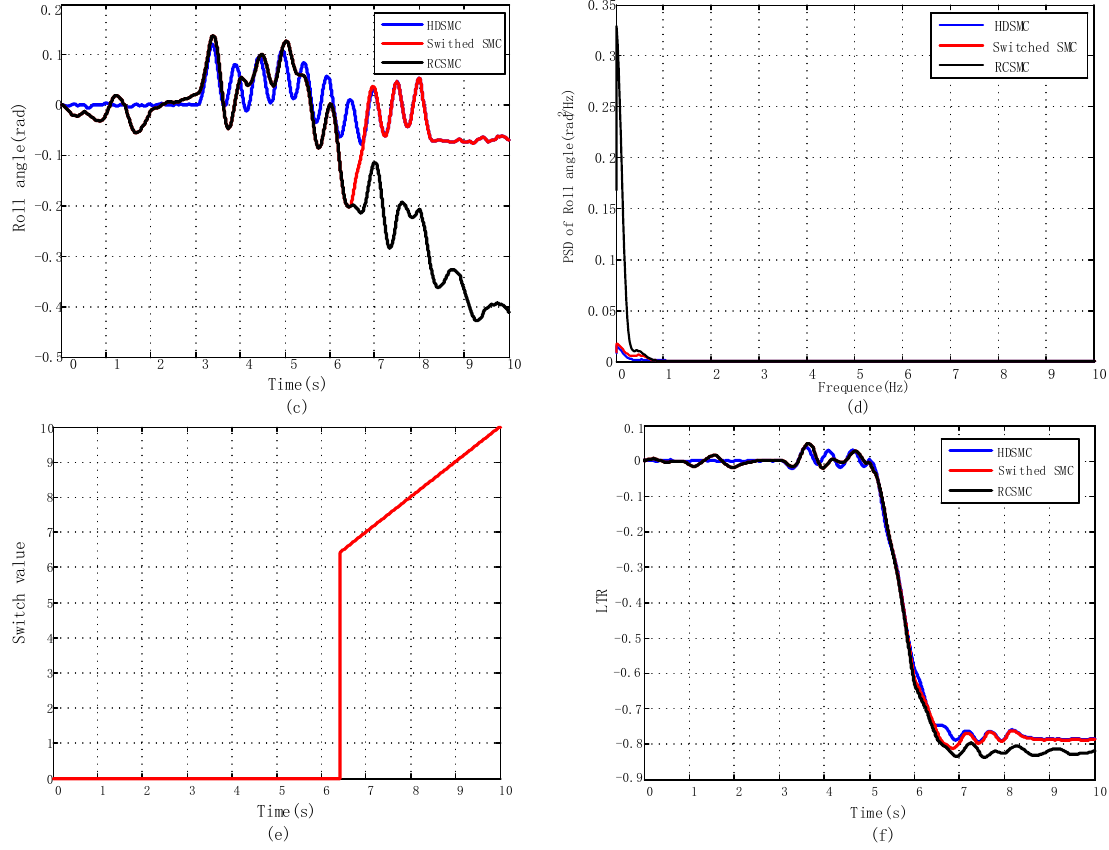
Figure 21. The rescue vehicle dynamic response based on the switch strategy under the bump road condition and the J-turn maneuver: ( a ) the vehicle body vertical acceleration in time domain; ( b ) the roll angle acceleration in time domain; ( c ) the vehicle body vertical acceleration in time domain in frequency domain; ( d ) the roll angle acceleration in frequency domain; ( e ) the switch value; ( f ) the LTR.